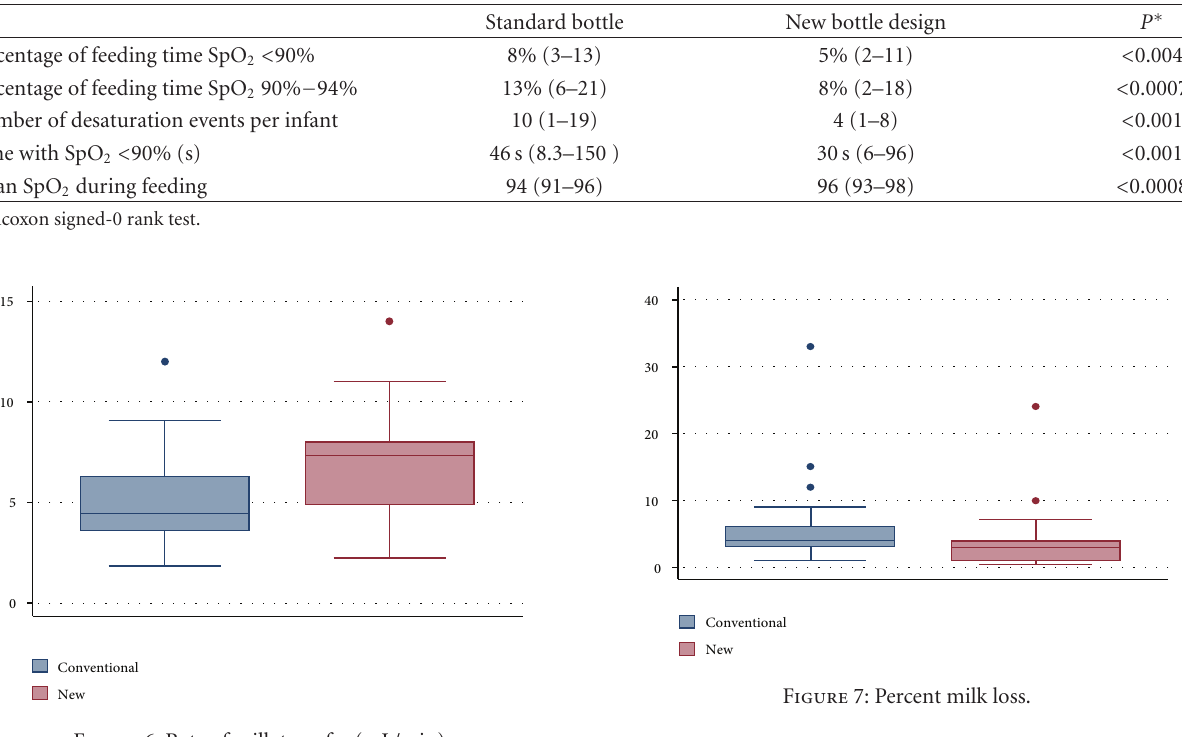
Table 2: Oxygen desaturation events, expressed as median and (interquartile range).